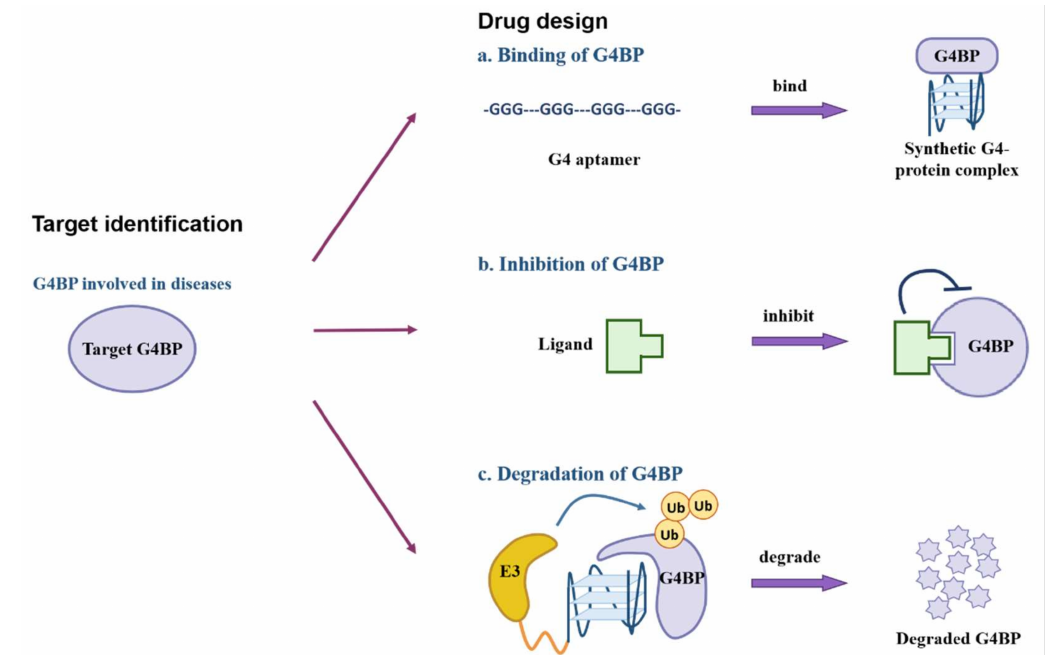
Figure 5. The schematic diagram for G-quadruplex-binding proteins as drug targets. The first step is target identification. After analyzing G4–protein interactions, G4BPs involved in disease-related pathways are chosen as potential drug targets. Secondly, three methods could be exploited for drug design. According to the G4–protein recognition mechanism, G4-based aptamers are designed to target specific proteins and form a synthetic G4–protein complex. Meanwhile, ligands would be used to inhibit G4BPs for synthetic lethality in cells with genetic defections. In addition, E3 ligase could be recruited for ubiquitin-mediated degradation of target